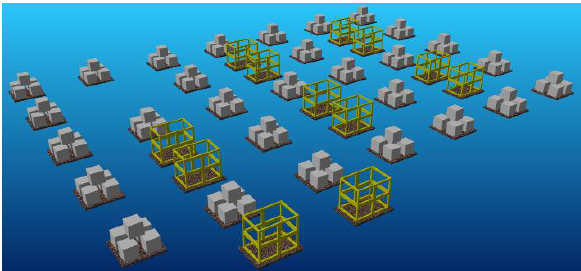
Figure 3. AR planned spatial